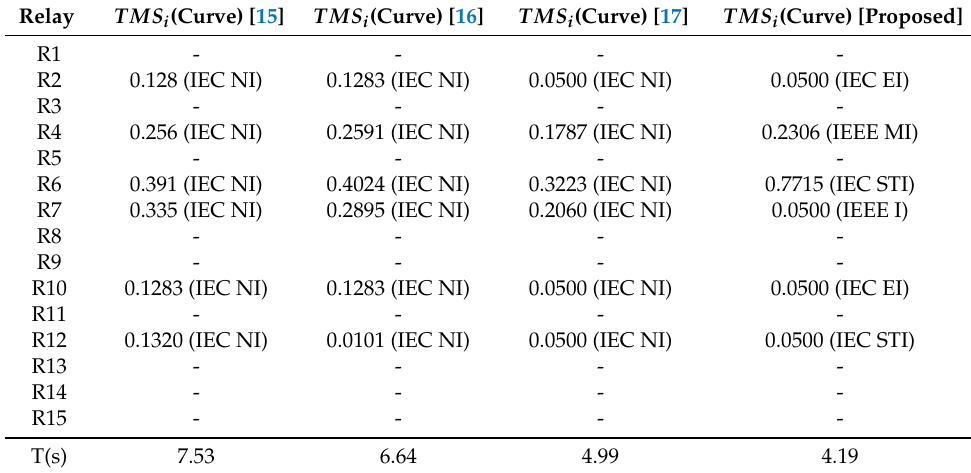
Table 4. Coordination parameters for OM1.